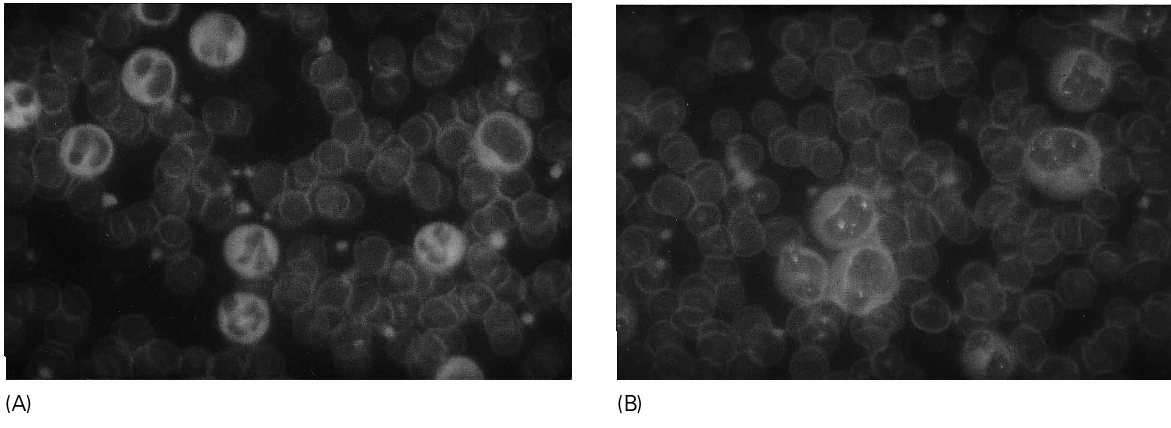
FIG. 8. In situ immunofluorescence analysis of PML proteins in human peripheral blood leukocytes. Indirect immuno- fluorescence analysis of a peripheral blood smear was performed using the specific mouse monoclonal antibody PG-M3 (B) and normal mouse IgG (A) as control as described in Materials and Methods. Specific immunolabelling can be detected in neutrophils and monocytes which were identified by morphologic